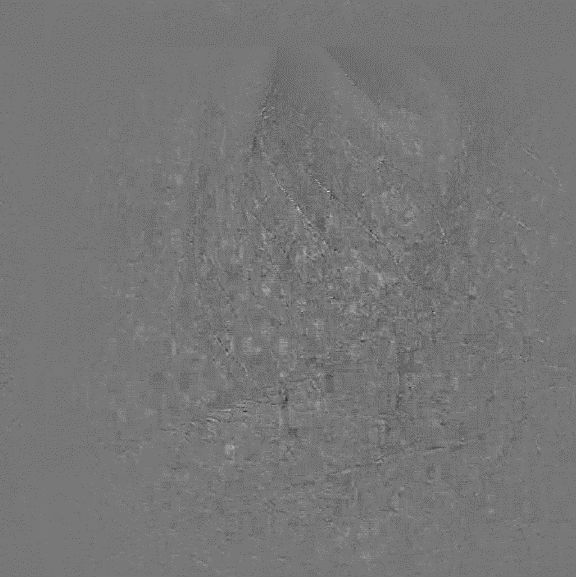
Figure 4. Differential image calculated by subpixel accuracy alignment using cross correlation.